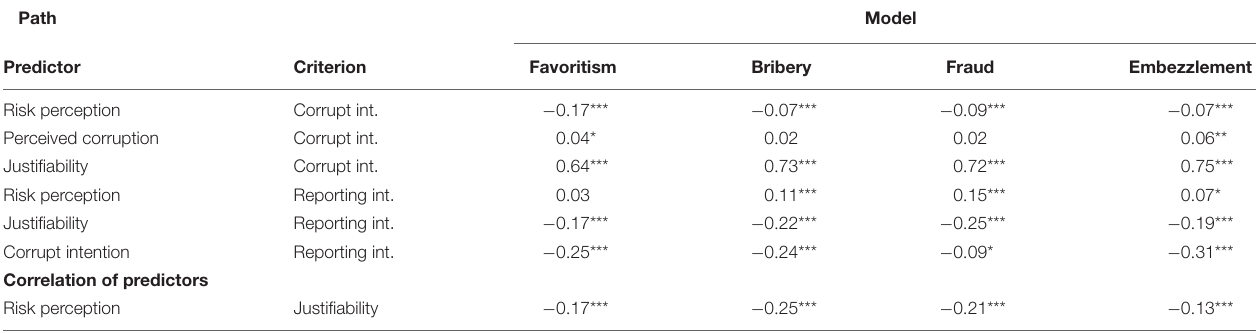
TABLE 3 | Standardized coefficients of path analysis for corruption models. Path Model Predictor Criterion Favoritism Bribery Fraud Embezzlement Risk perception Corrupt